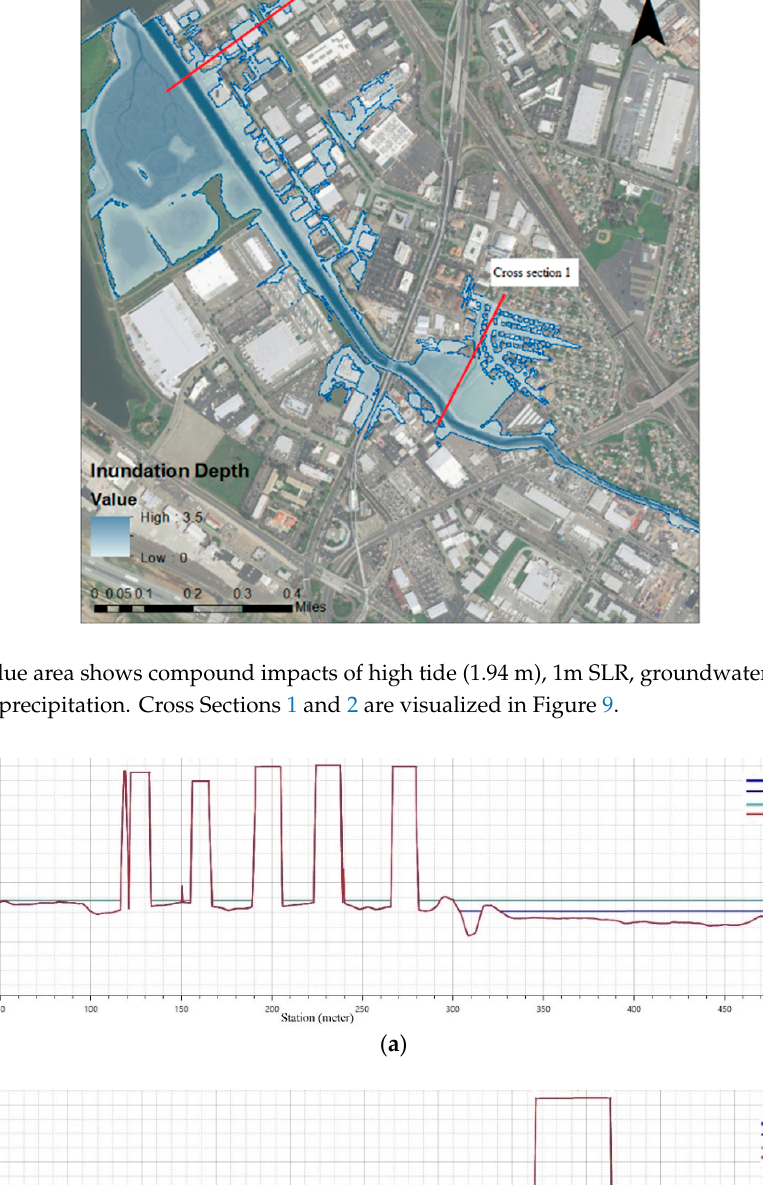
ff erent scenarios at ( a ) Cross Section 1, and ( b ) Cross Section Figure 9. Water elevation in different scenarios at ( a ) Cross Section 1, and ( b ) Cross Section 2. Figure 9. Water elevation in di